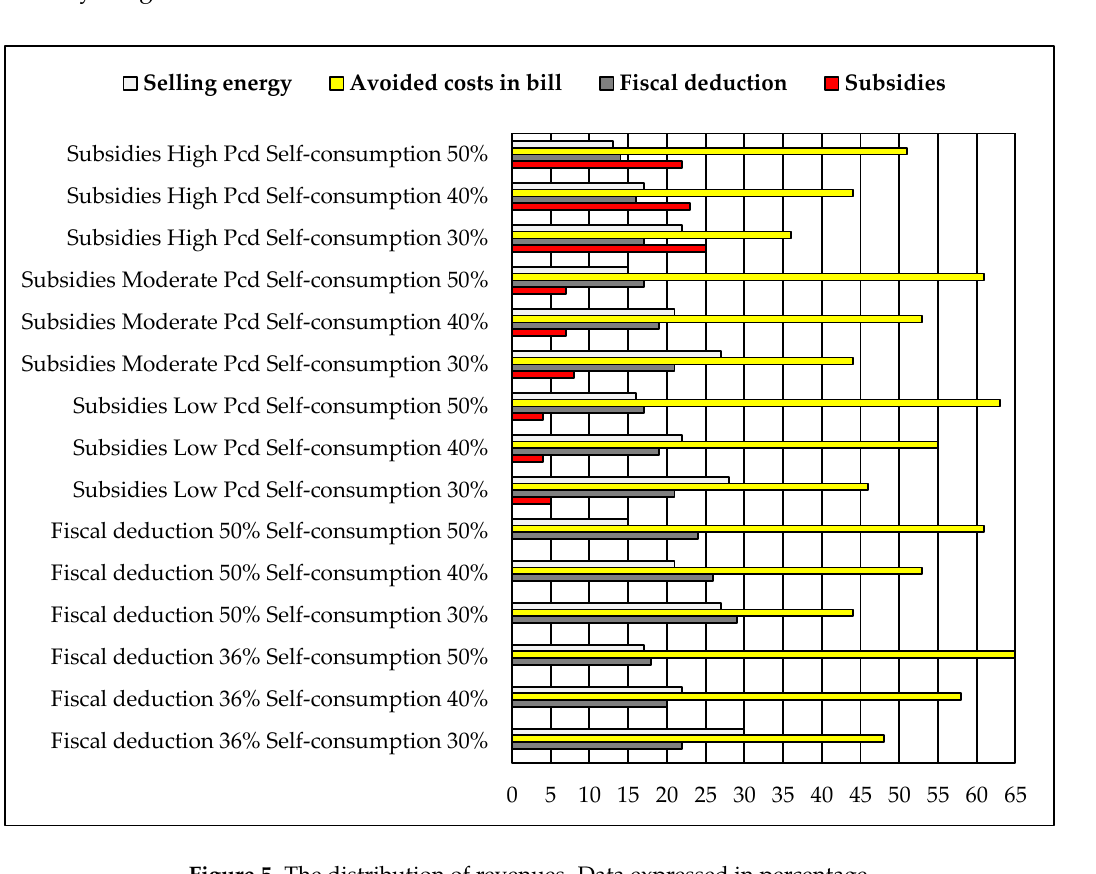
Figure 5. The distribution of revenues. Data expressed in percentage.